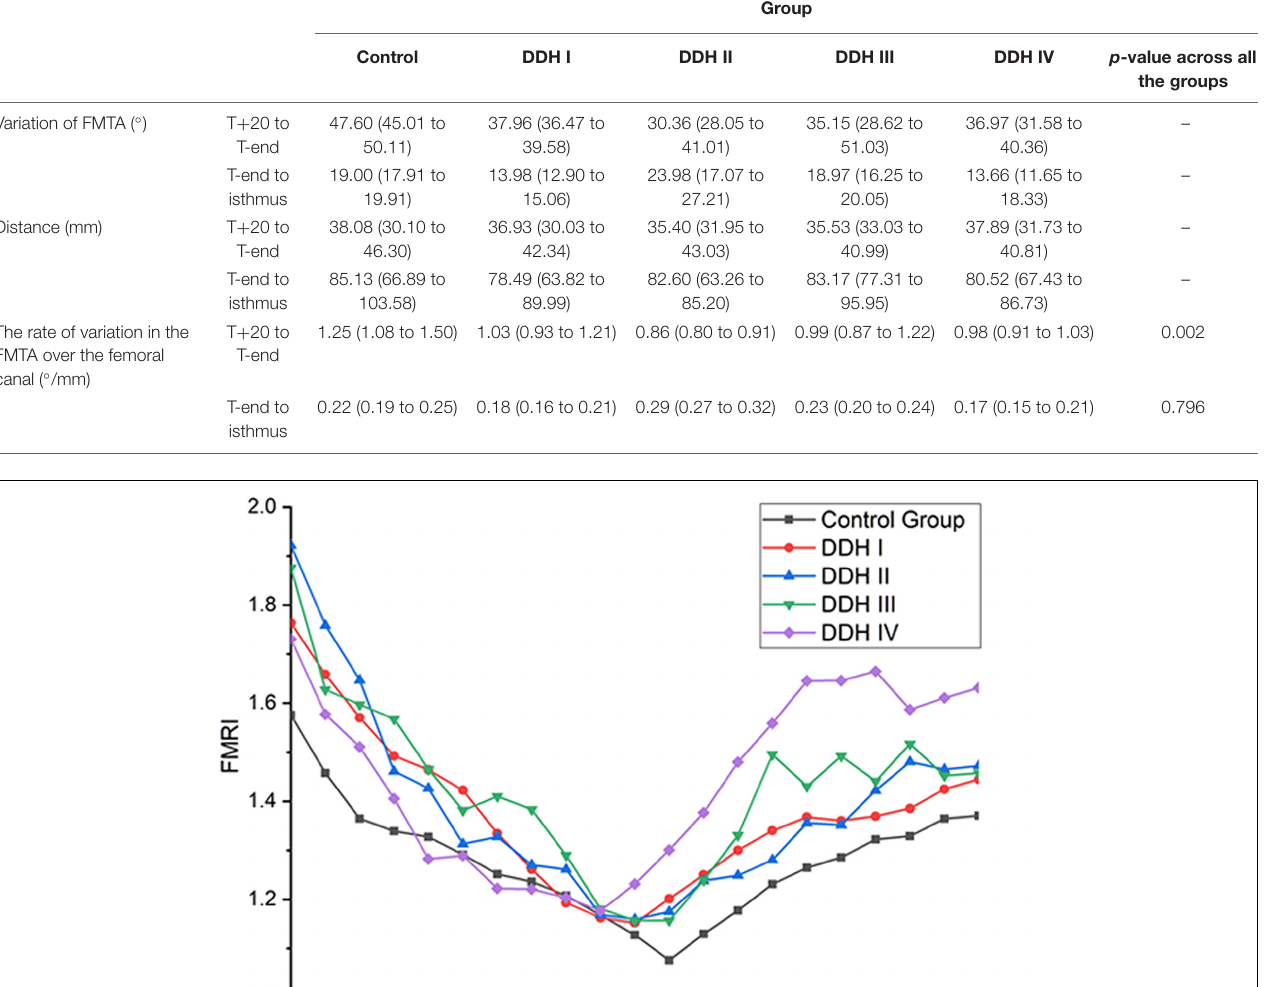
TABLE 4 | Detailed information on the variation of femoral medullary torsion angle (FMTA).